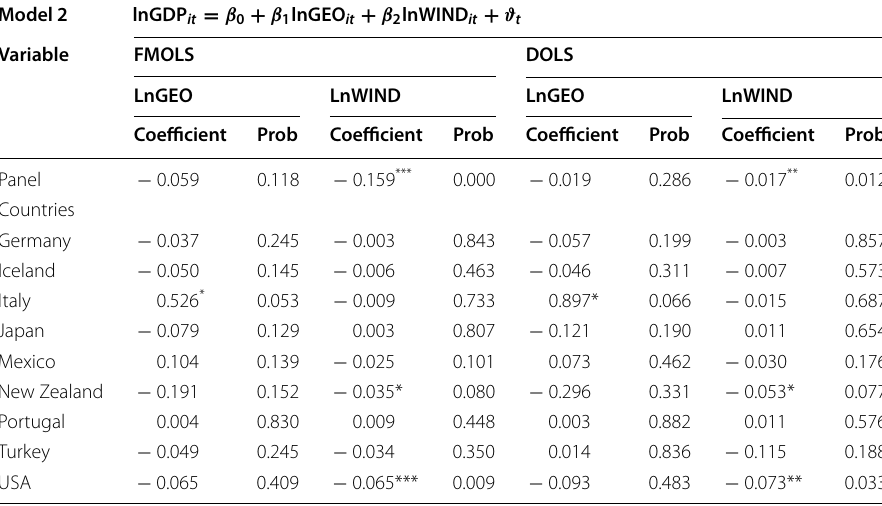
Table 6 Model 2 FMOLS and DOLS coefficient estimator results Model